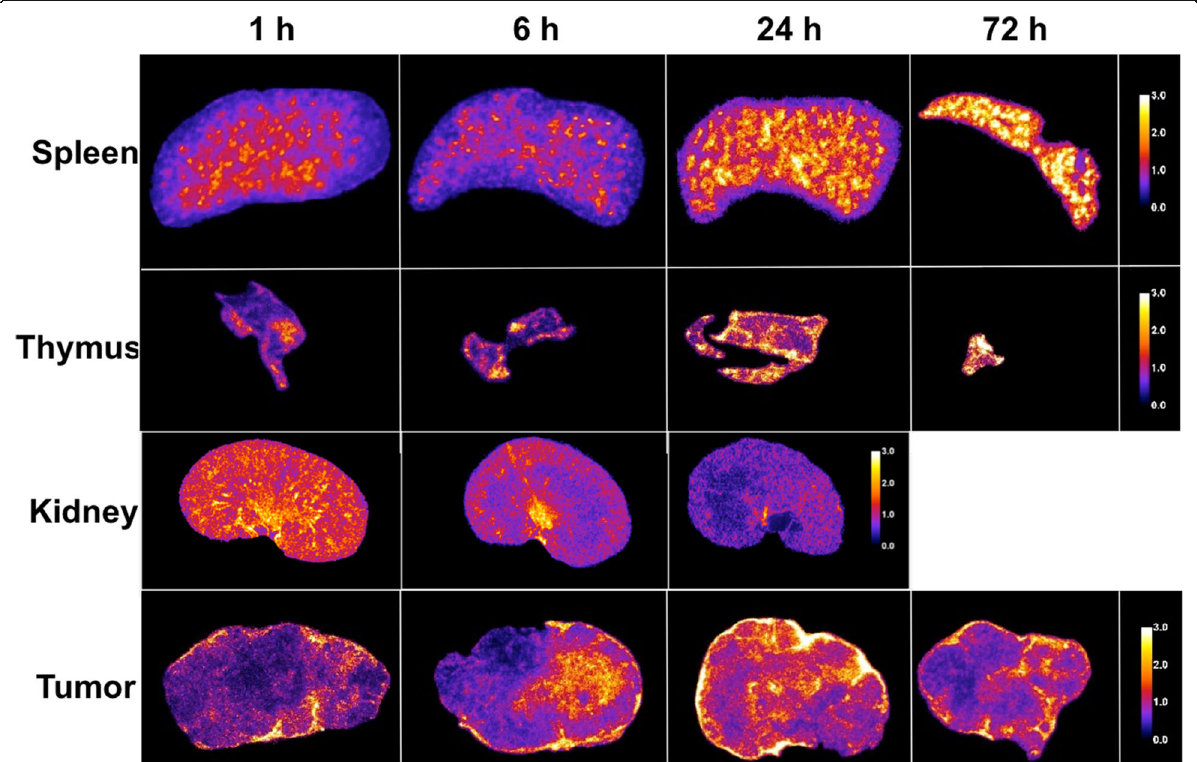
Fig. 6 Alpha-camera images for the spleen, thymus, kidney, and tumor following i.v. administration of 225 Ac-DOTA-anti-PD-L1-BC (67 kBq, 3 mg/kg). The scale is normalized for each tissue so that the average intensity across each row is set to 1. A 72-h kidney image and 144-h images for all other organs could not be obtained due to low